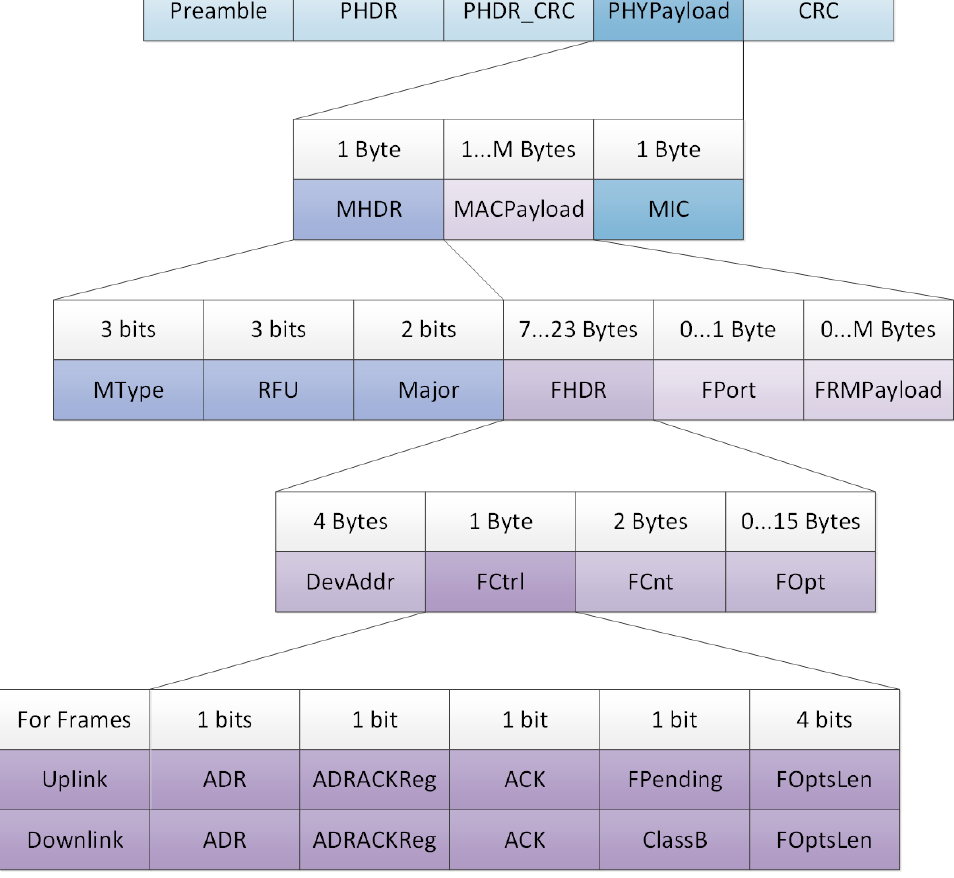
Figure 7. LoRaWAN packet structure [20,22].